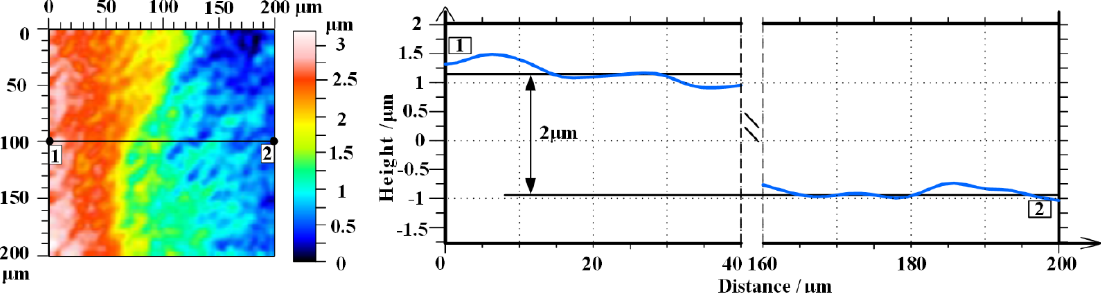
Figure 10. Oxidation depth of the chemical cleaned surface after PEP-MP for 30 s (l chemical cleaned area, 2 polished